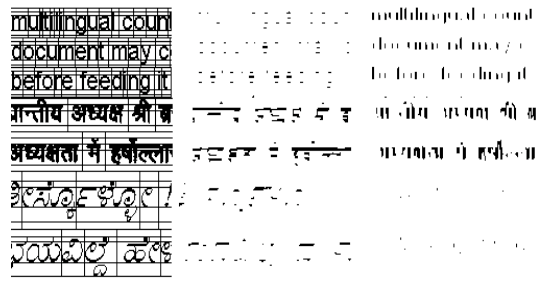
Figure 5. Sample output image containing all the three languages Kannada, Hindi and English.